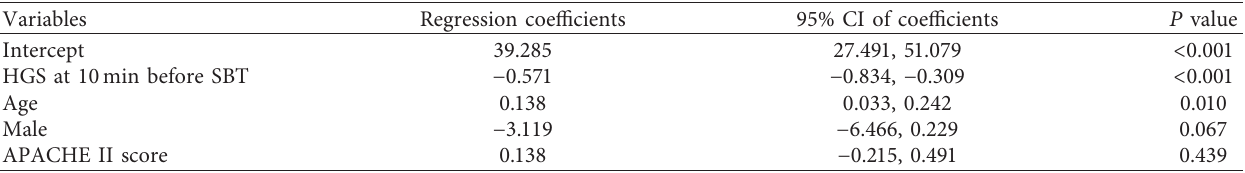
APACHE II score HGS, handgrip strength; SBT, spontaneous breathing